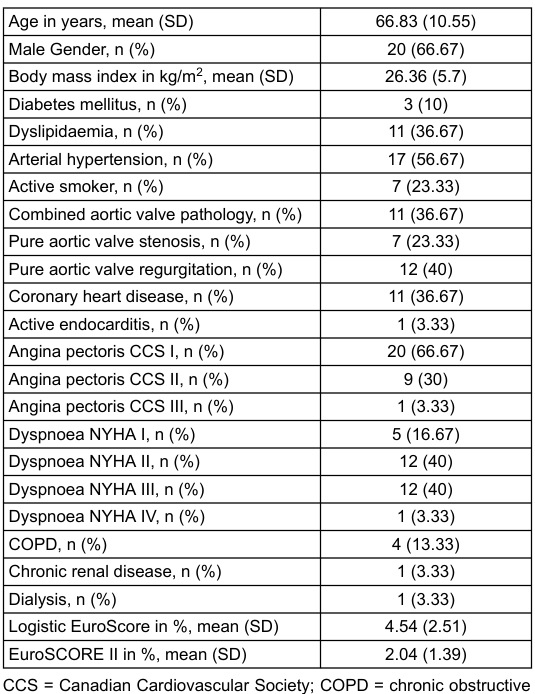
Table 1: Demographic data (n = 30).